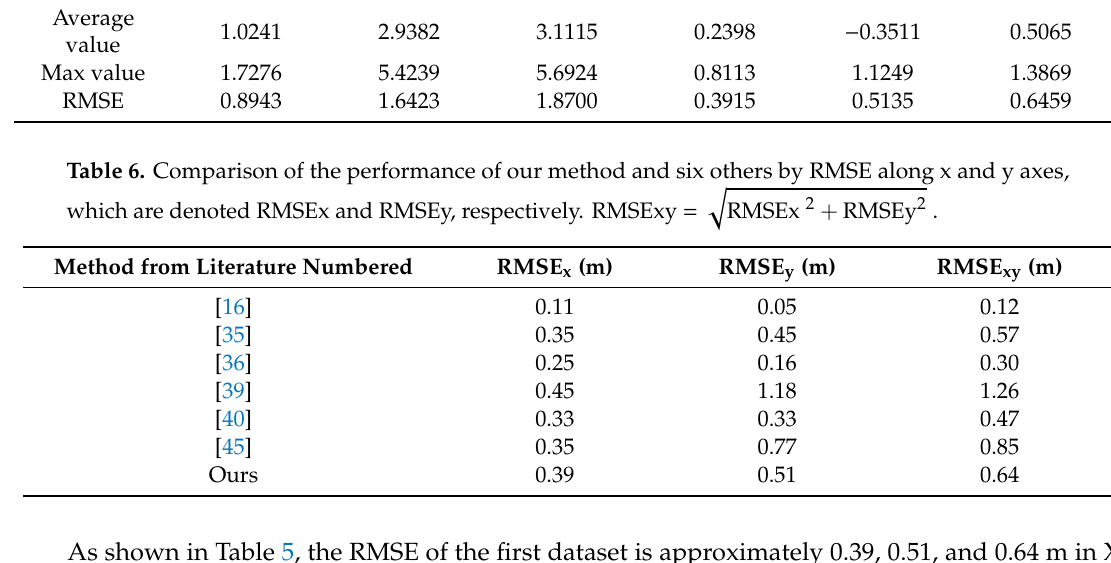
Table 5. Planar accuracy of the georeferenced images.